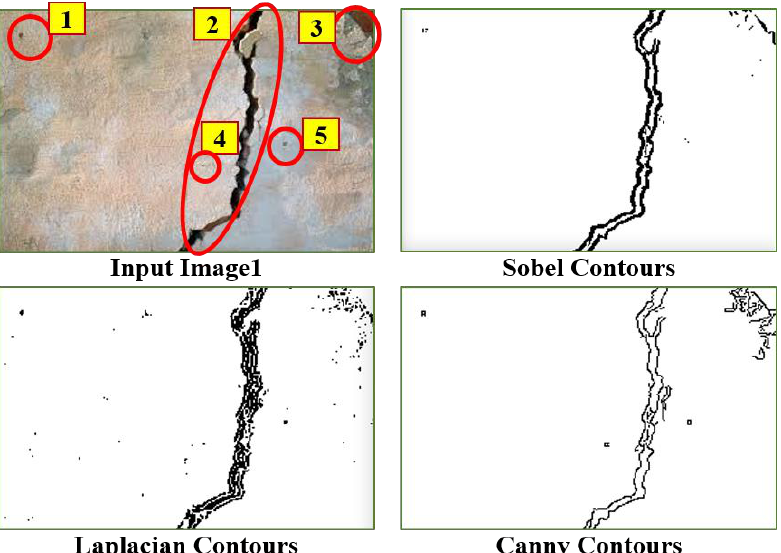
Figure 10. Comparison of the contour detectors with 5 cracks.